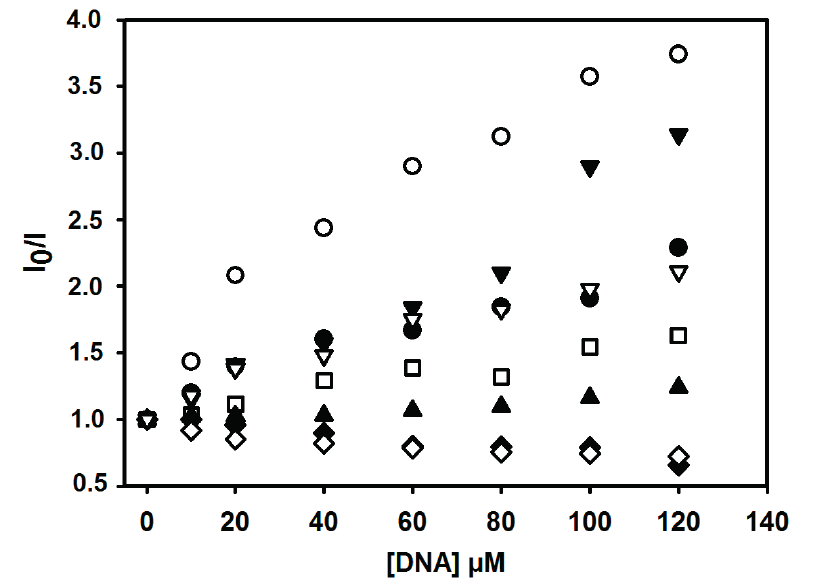
Figure 3. Relative fluorescence intensities of acridine-thiosemicarbazone derivatives 3a ( ● ), 3b ( ◊ ), 3c ( ▲ ), 3d ( ), 3e ( ♦ ), 3f ( ○ ), 3g ( □ ) and 3h ( ▼ ), upon addition of ctDNA in Tris buffer (0.01 M, pH =